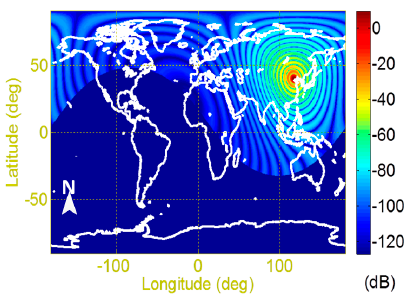
Figure A2. GEO SAR SINR simulation based on the SMOS data (28 February 2011).